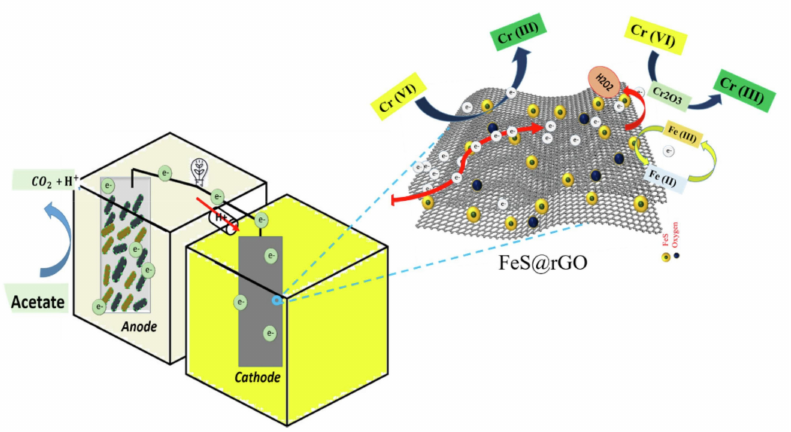
Figure 12. Possible mechanism of Cr(VI) reduction at FeS@rGO decorated cathode in MFC. Repro- duced with permission from